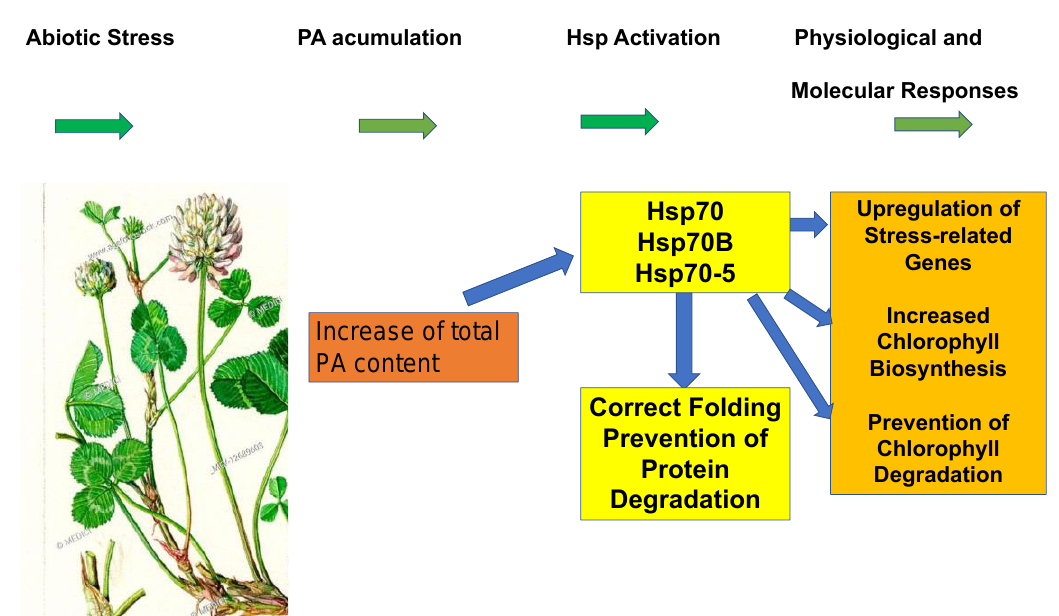
Figure 4. Exogenous spermidine supplementation in white clover supports stress tolerance after abiotic stress. Spd-treated white clover shows increased PA accumulation and Hsp activation under abiotic stress conditions with subsequent physiological and molecular responses of the plant, which finally lead to protection.